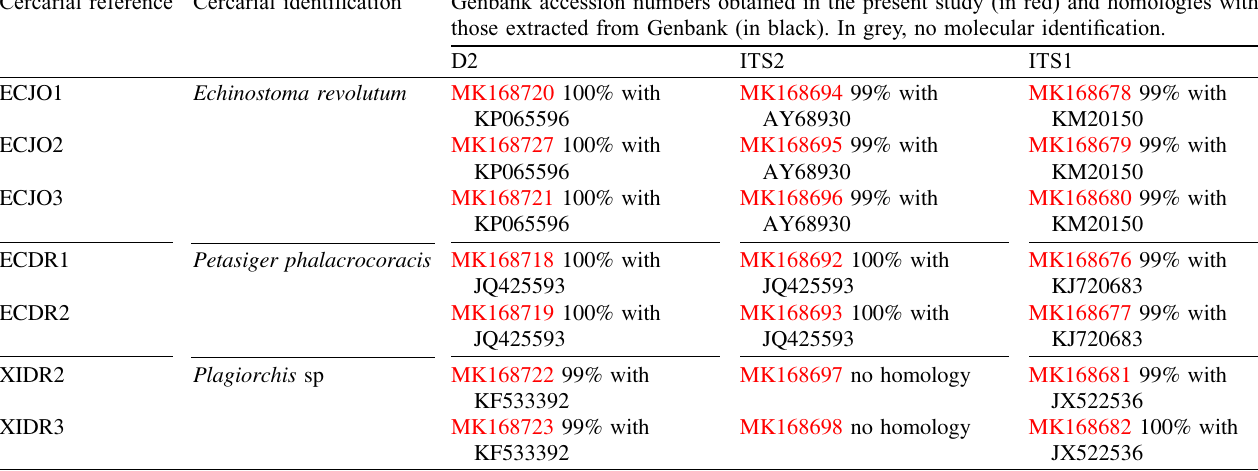
FO: ocellated pigmented furcocercariae, LF: furcocercariae with or not eyes spots, EC: cercariae of Echinostomidae, XI: